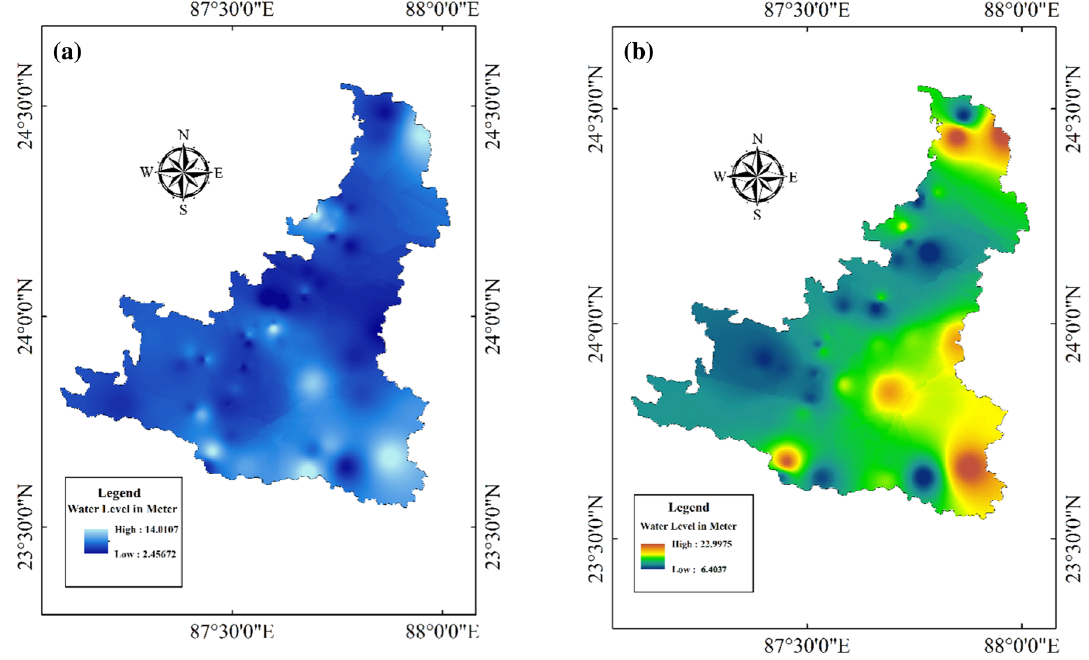
Fig. 10 Pre-monsoon groundwater level in 1996 and